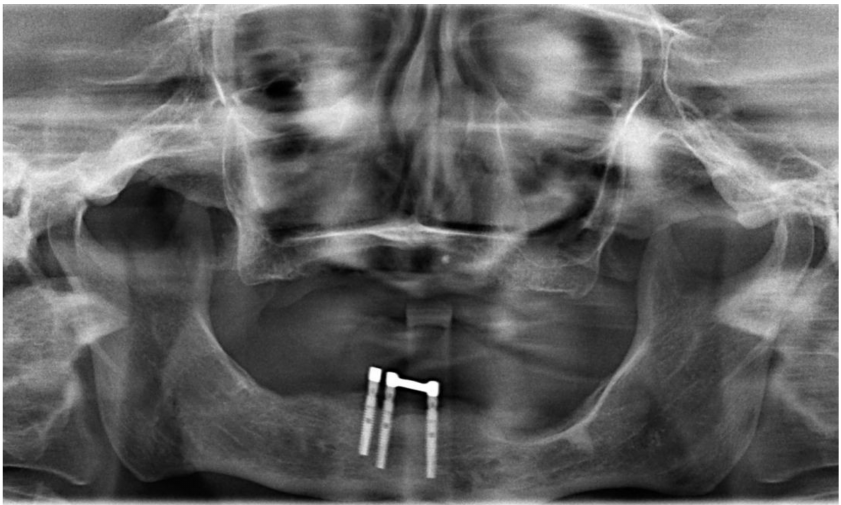
Figure 1. Preoperative panoramic radiograph with complete edentulism in the maxilla and failing implants in the mandible.